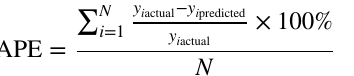
gData Model Training n and by op(cid:26)mizing processin the hyperparmeters Random split the data; Tes(cid:26)ng: Training